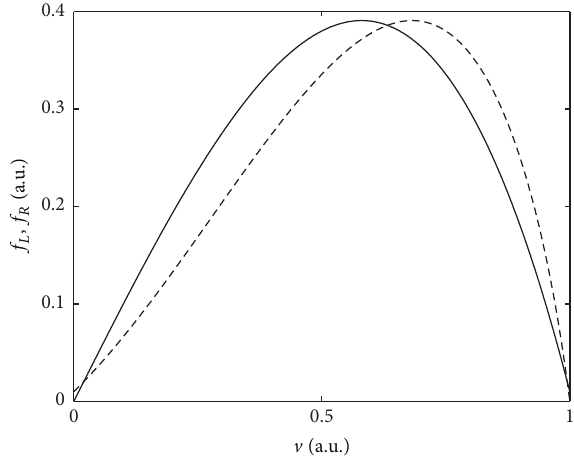
Figure 7: The functions 𝑓 𝐿 (solid line) and 𝑓 𝑅 (dashed line) of (19) in the symmetric case. The signaling pathway model is bistable. Parameters: 𝛼 = 1.5 ( 𝑟 1 = 𝑟 2 = 𝑟 = 2 ); all other parameters are as in Figure